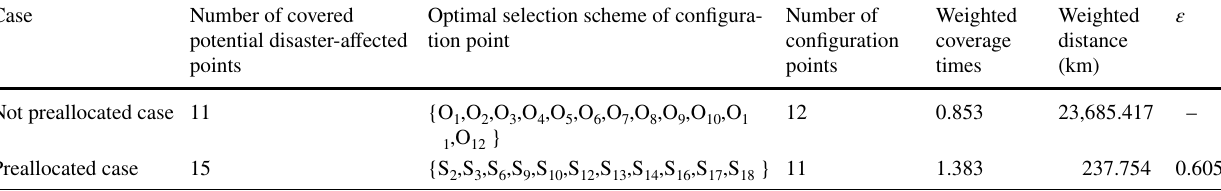
Table 9 Calculation results of the two cases under 6 hours demand time